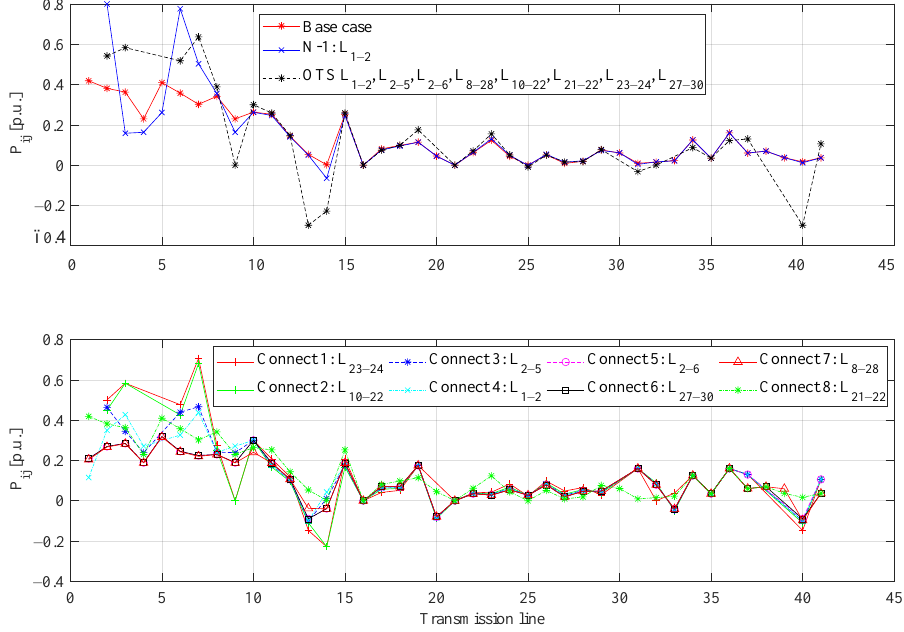
Figure 5. Power flows behavior in the 30-bar system.